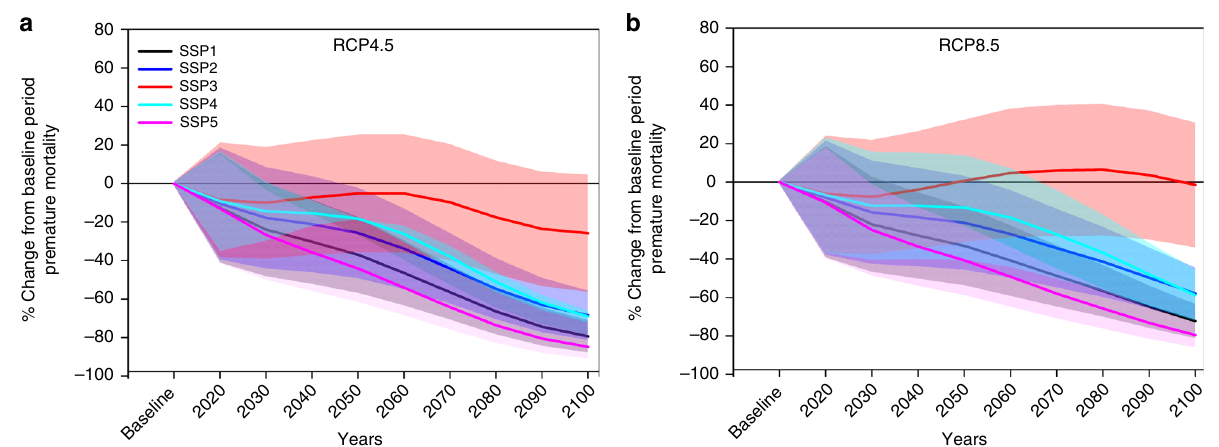
Fig. 3 Projected change in premature mortality due to PM 2.5 exposure w.r.t. baseline period over the Indian landmass. Projected percentage changes in premature mortality burden from ambient PM 2.5 exposure in India for the fi ve SSP scenario population using projected baseline mortality under a RCP4.5 and b RCP8.5 scenarios. The range (1 – 99%) of premature mortality (as a function of standard error in baseline mortality model and the range of PM 2.5 from CMIP5 models) is shown as shades around the mean values as bold lines.